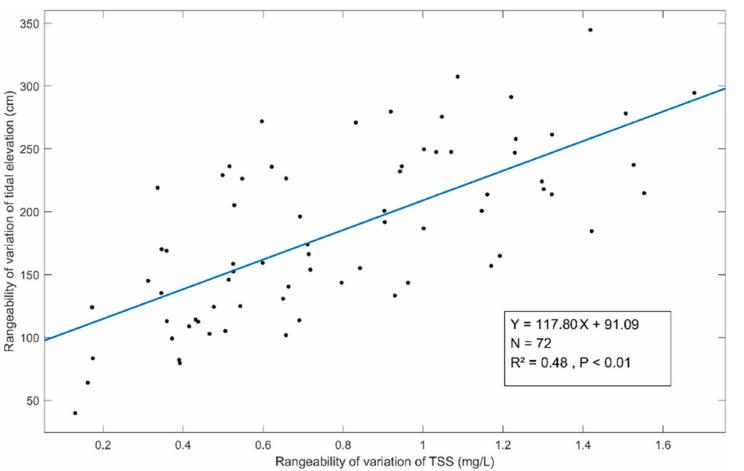
Figure 10. Relationship between rangeability of variation in TSS concentration and rangeability of variation in tidal elevation in one